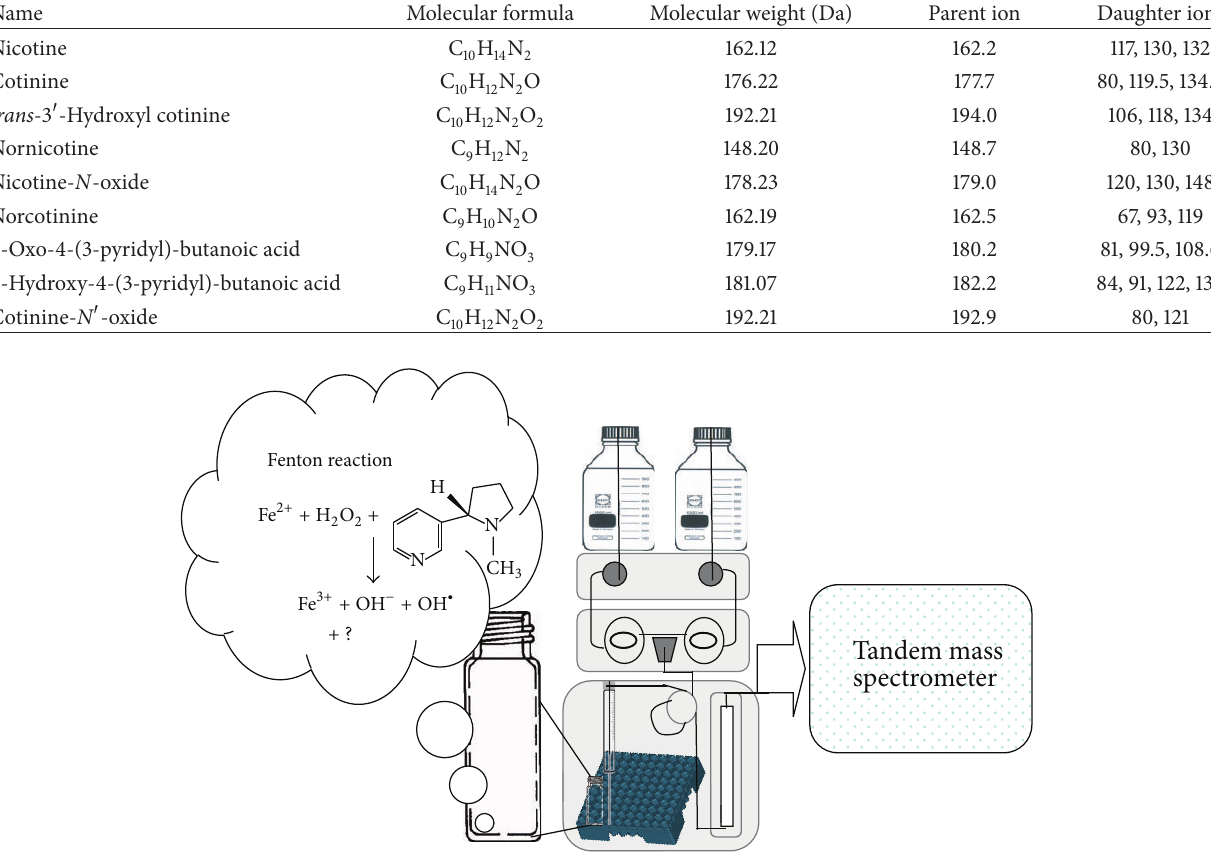
Figure 2: The schematic representations of experimental apparatus and Fenton reaction oxidative processes. Nicotine reacted with hydroxyl free radical in sample bottle and nicotinic oxidative products or metabolic derivatives were injected via syringe into analytic column in